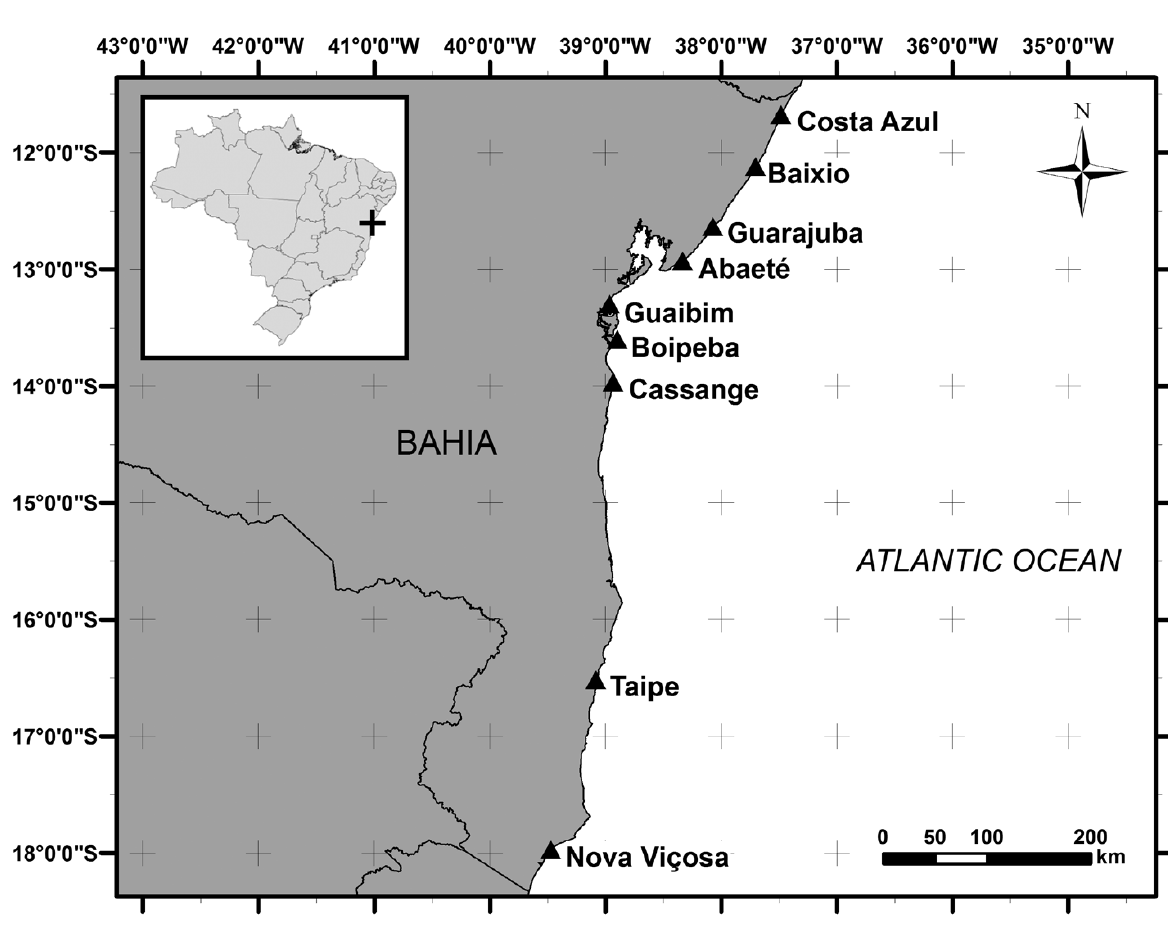
Fig. 1 - Sampled localities of nine restinga ecosystems along in the coast of the State of Bahia, northeastern